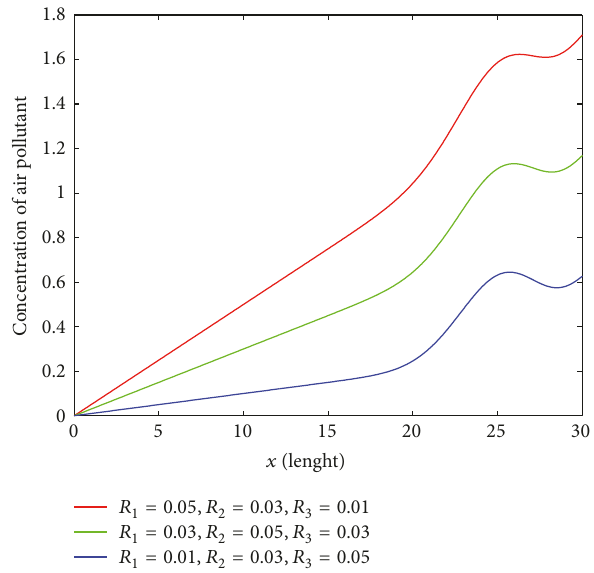
Figure 25: Compare the concentration of air pollutant at 𝑥 = 60 m , 𝑦 = 14 m , 𝑧 = 4 m of 3 averaged zone sources in different